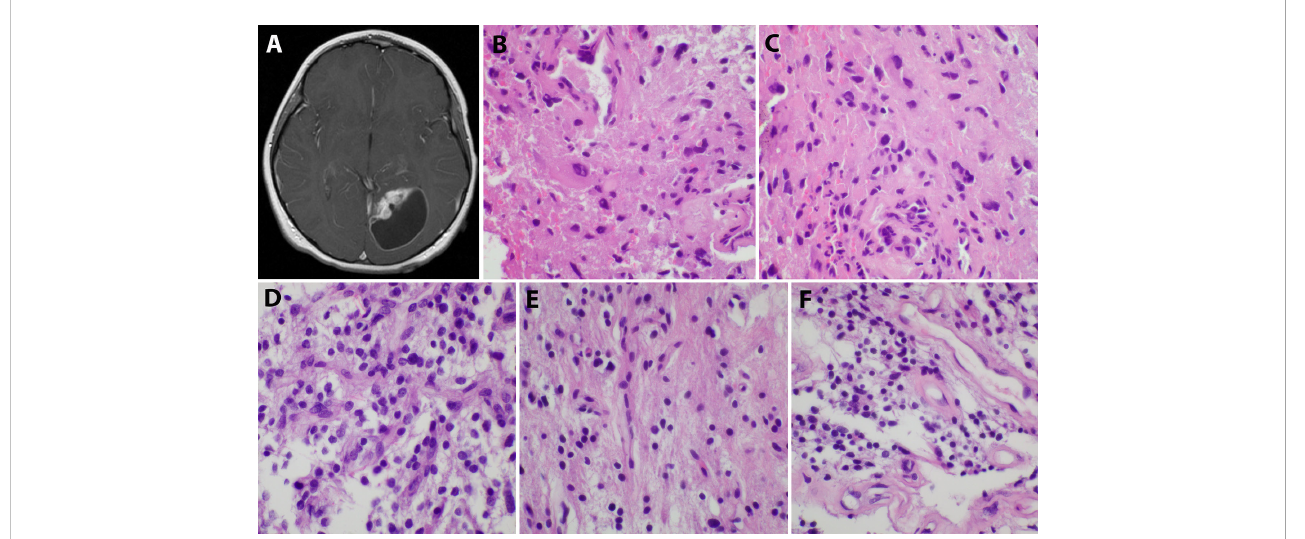
FIGURE 1 Initial imaging presentation and histological studies of the tumor. (A) . Imaging showed a cystic lesion with an enhancing mural nodule in the left occipital lobe; (B, C) . H&E staining of the initial tumor revealed a low-grade astrocytic proliferation with scattered hyperchromatic nuclei and eosinophilic cytoplasm; (D – F) . The second recurrent tumor displayed low-grade astrocytic features similar to the original tumor and some endothelial